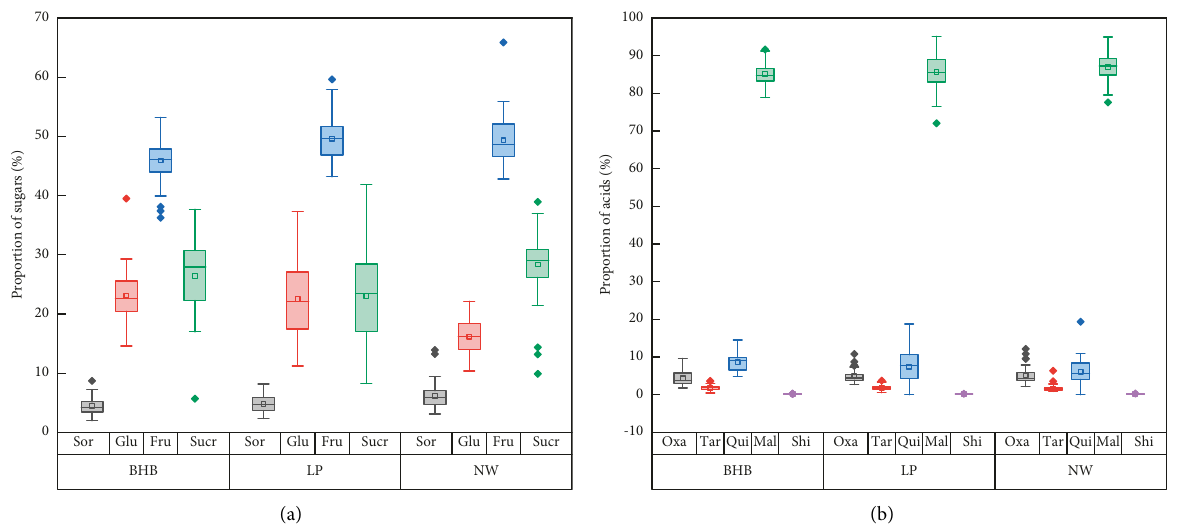
Figure 1: The proportions of soluble sugars (a) and organic acids (b) in